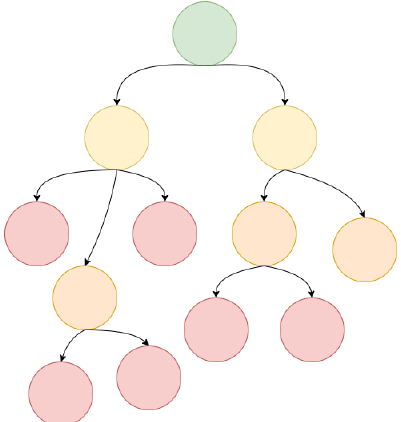
Figure 12. Representation of the decision tree model’s structure.